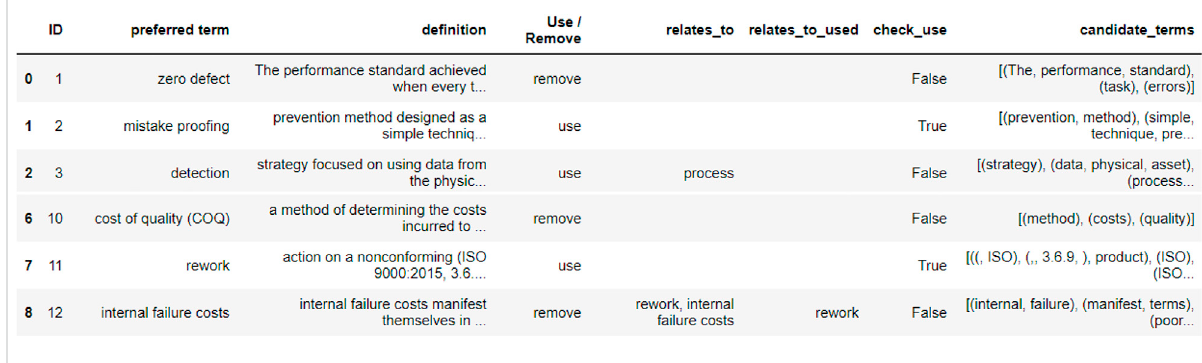
FIGURE 4 Example of the results achieved by applying the developed NLP